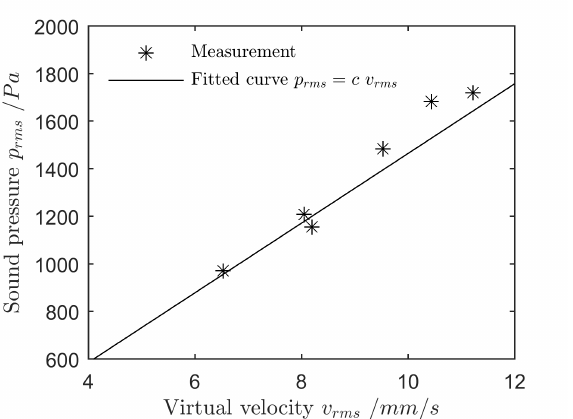
Figure 15. Sound pressure (measured with microphone) versus virtual velocity (measured with laser